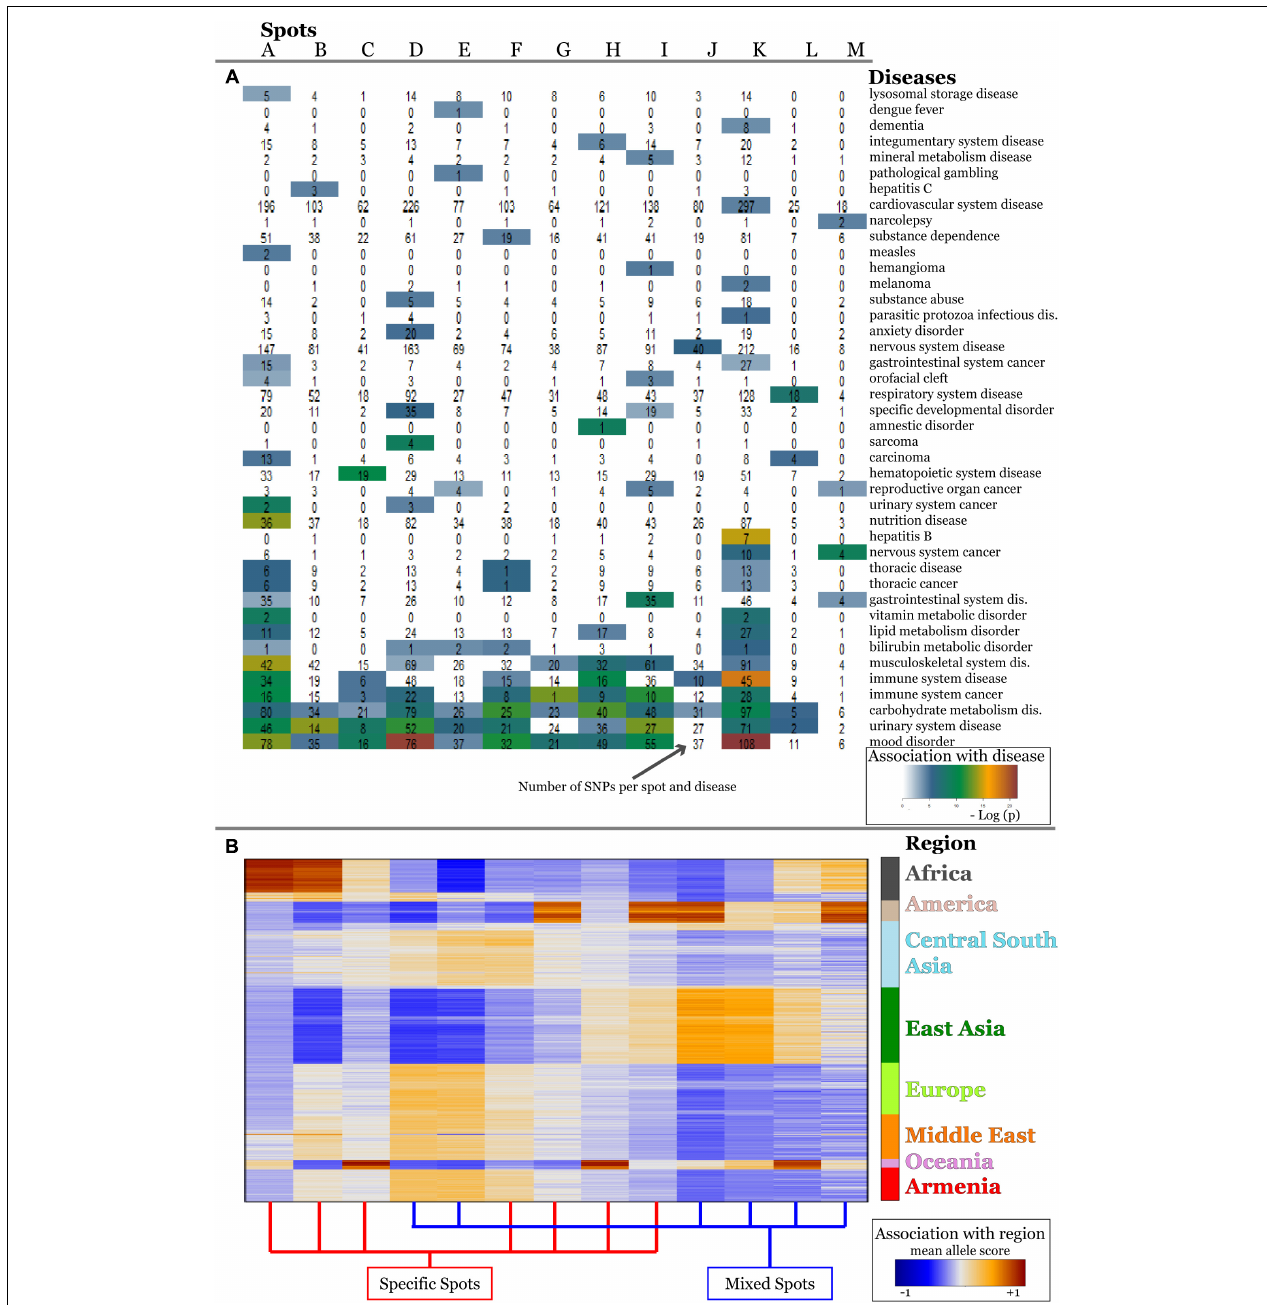
FIGURE 6 | Associations of spots with diseases (A) and with geographic regions (B) are shown as heatmaps. Diseases represented with high numbers of SNPs in the background distribution accumulate in the lower part of the heatmap (A) . More rarely-presented diseases frequently associate with one or two spots only (A) which, in turn, are assigned to specific regions according to the respective mean allele score (B) . SNPs associated with mood disorders are enriched in spots having high MAF in Europeans and East Asians which corresponds to the enrichment of GO-terms related to neuronal functions in Figure 5 .